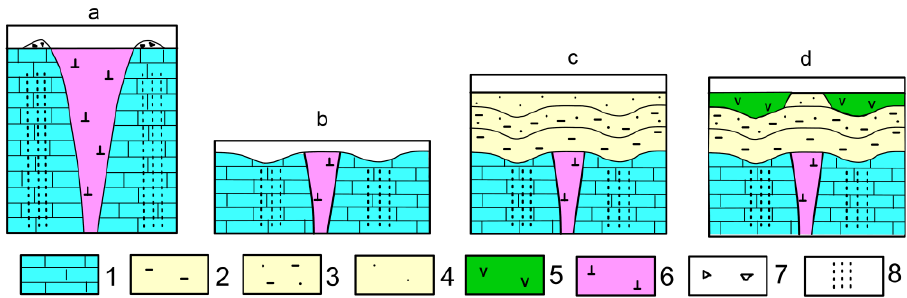
Figure 3. Scheme of evolution of kimberlite pipes and surrounding rocks. ( a )—pipe after the explosion, ( b )—pipe after the denudation and erosion, ( c )—pipe after the sediments’ accumulation, ( d )—pipe after the intrusion of dolerite sill. 1—carbonate rocks, 2—carbonaceous siltstones, 3—sandstones and siltstones, 4—sands, 5—dolerites, 6—kimberlites, 7—explosive formations, 8—fractures zones.